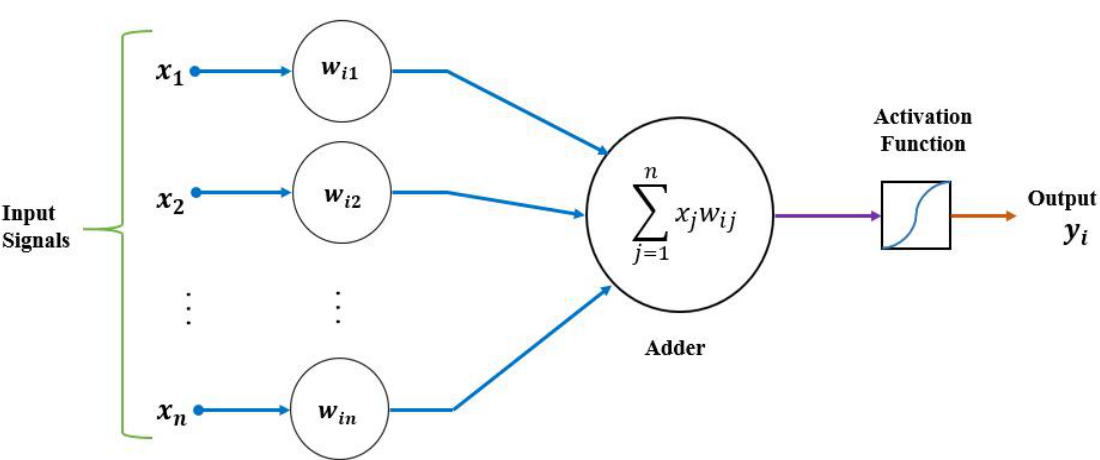
Fig. 2: Structure of an artificial